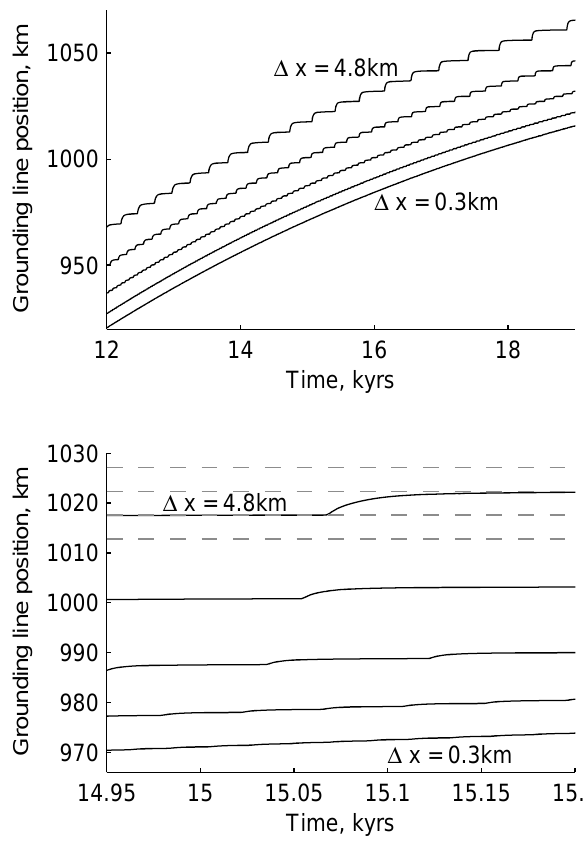
Fig. 3. Close up of the LI B1 advance simulations shown in Fig. 2 showing the step like nature of grounding line advance in detail. Resolutions are 0.3km, 0.6km, 1.2km, 2.4km and 4.8km. The horizontal dashed lines in the lower plot indicate grid point loca- tions at 1x = 4.8km resolution between 1010km and 1030km.